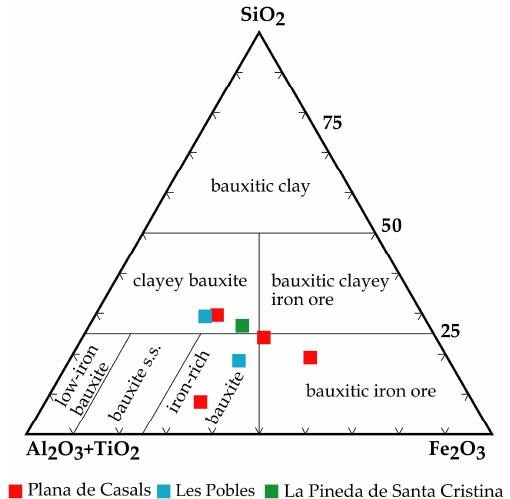
Figure 5. Whole rock SiO 2 -Fe 2 O 3 -Al 2 O 3 +TiO 2 ternary plot of the studied bauxitic samples; bauxite classification fields are after [22].